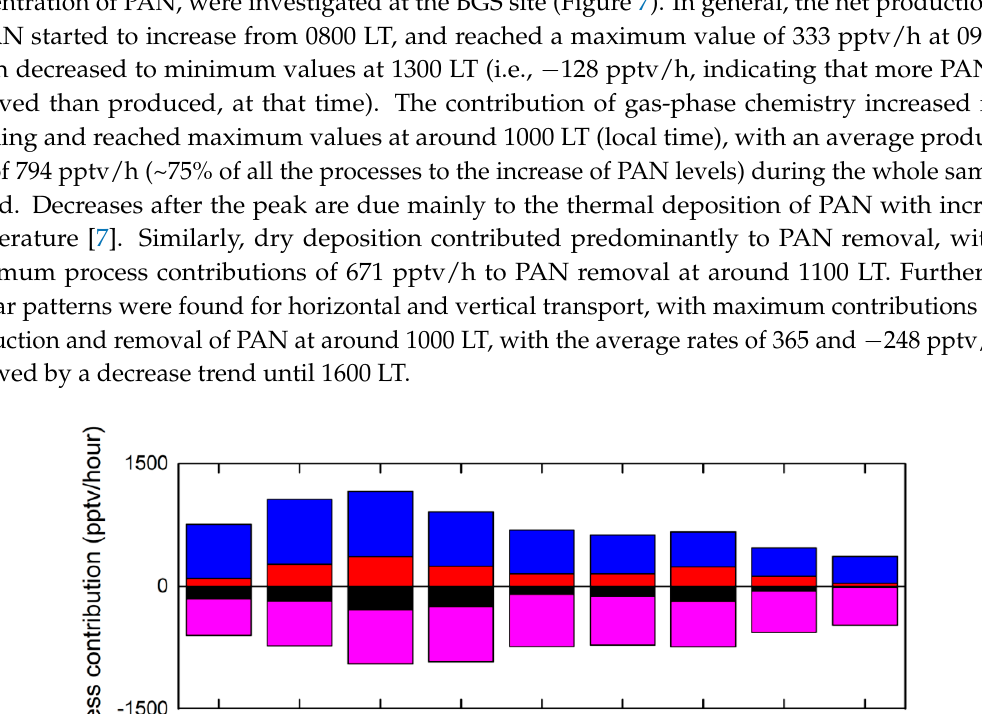
Figure 6. Difference of PAN concentrations between 800 m and surface ( left panel, PAN at 800m − PAN at surface ) and difference of gas-phase chemistry between 800 m and surface ( right panel, CHEM at 800m − CHEM at surface ).